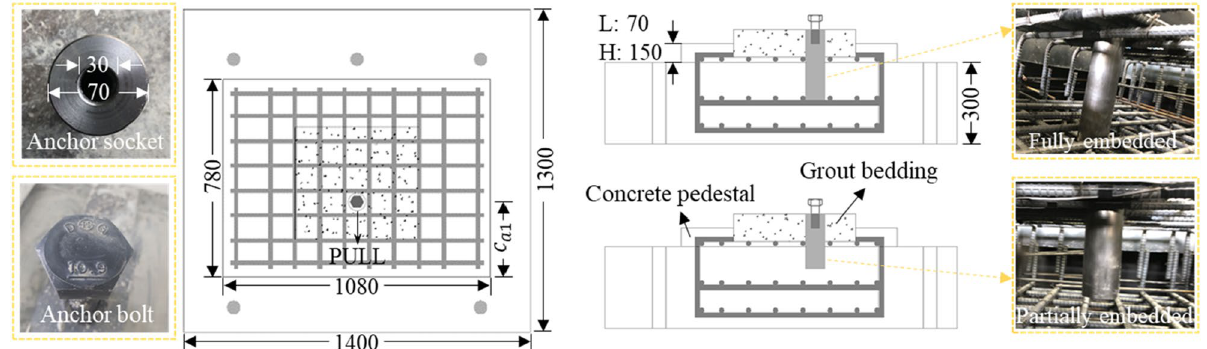
Figure 4. Geometric details of test